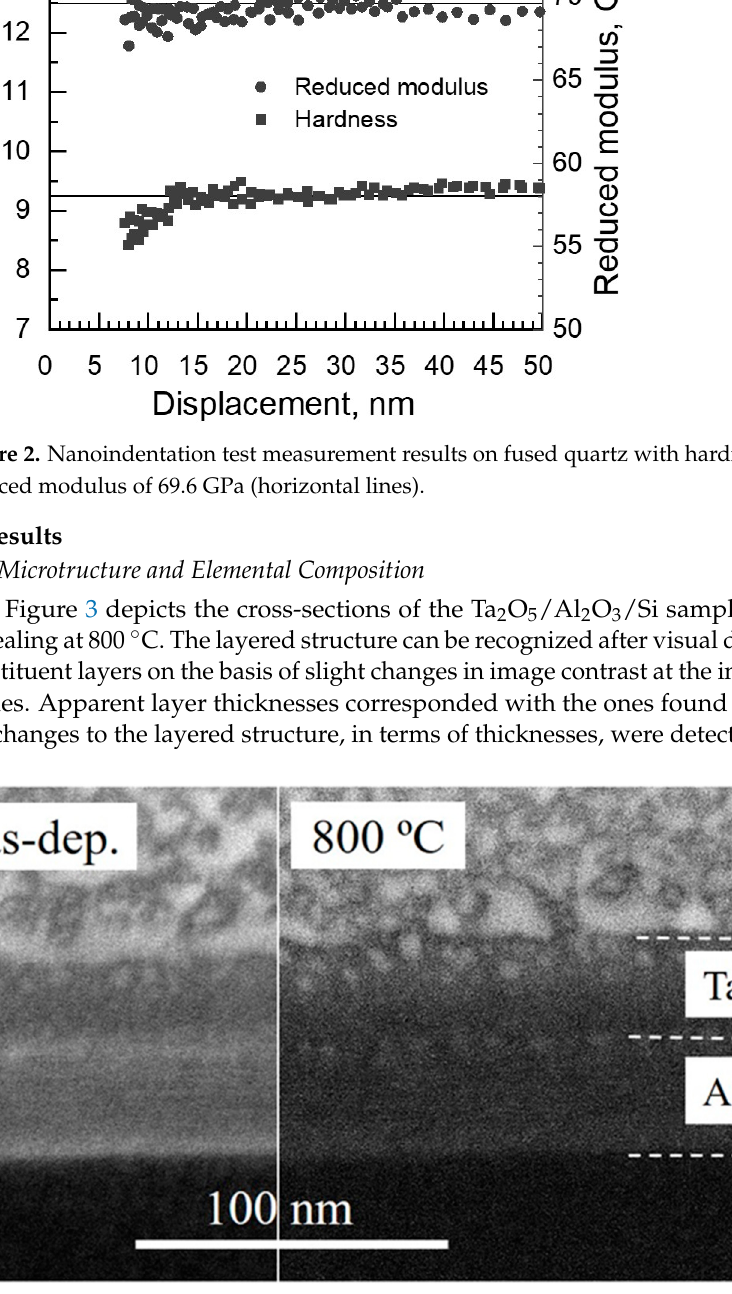
Figure 3. SEM images of FIB-made cross-sections of as-deposited and annealed Ta 2 O 5 /Al 2 O 3 /Si sam- ple with a protective platinum coating.